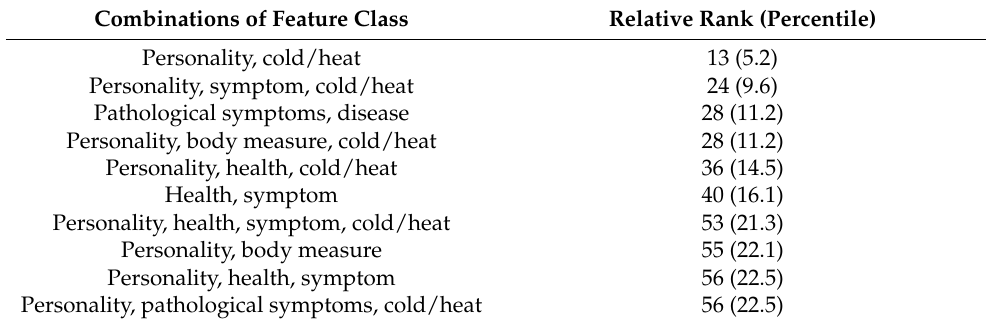
Figure 4. Entropy modeling for SC type. The left figure shows the possible state that the SC type is connected to the nodes of various feature classes, which indicates that the SC type includes information about various classes. On the other hand, the right figure indicates another possible state that the SC type has no connection, which indicates that the SC type contains limited information. Table 5. Feature class combination related to SC type according to relative entropy ranking.